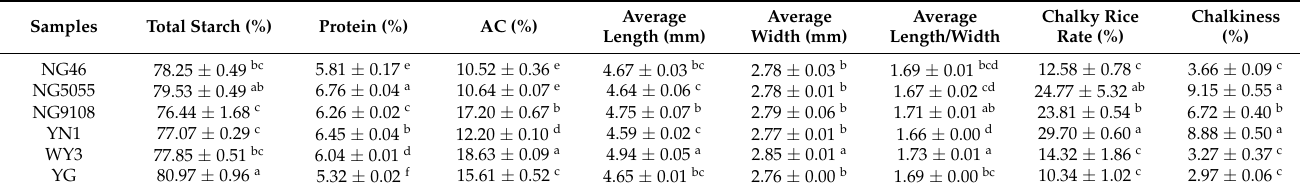
Table 2. Basic compositions and appearance qualities for six kinds of Japonica